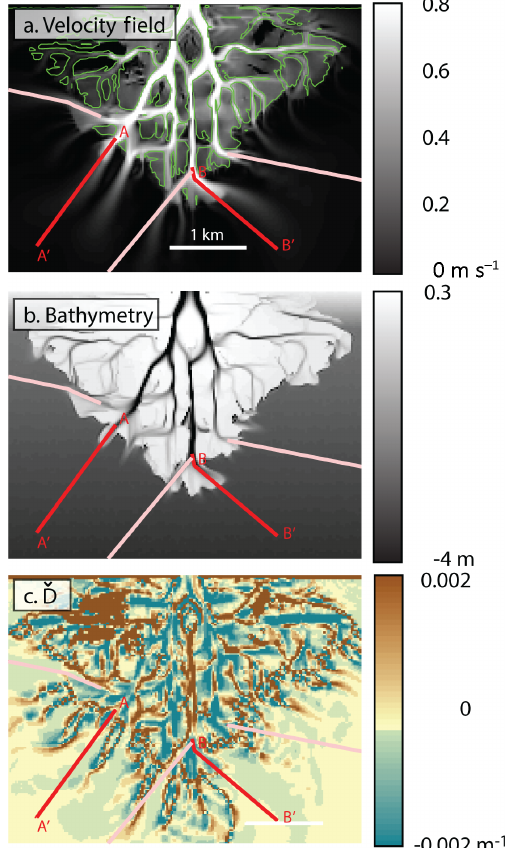
Figure 4. Method for comparing ˇ D to bathymetry using a Delft3D numerical simulation (run A1e1). (a) The velocity field and − 0 . 3m MSL (green) elevation contour are displayed and transects (pink and red lines) are drawn extending from the largest distributary net- work channels. (b) The bathymetric profile is collected along each transect. (c) ˇ D is calculated, and transects of ˇ D are collected along the transects. Transects A–A’ and B–B’ are shown in Fig. 5.